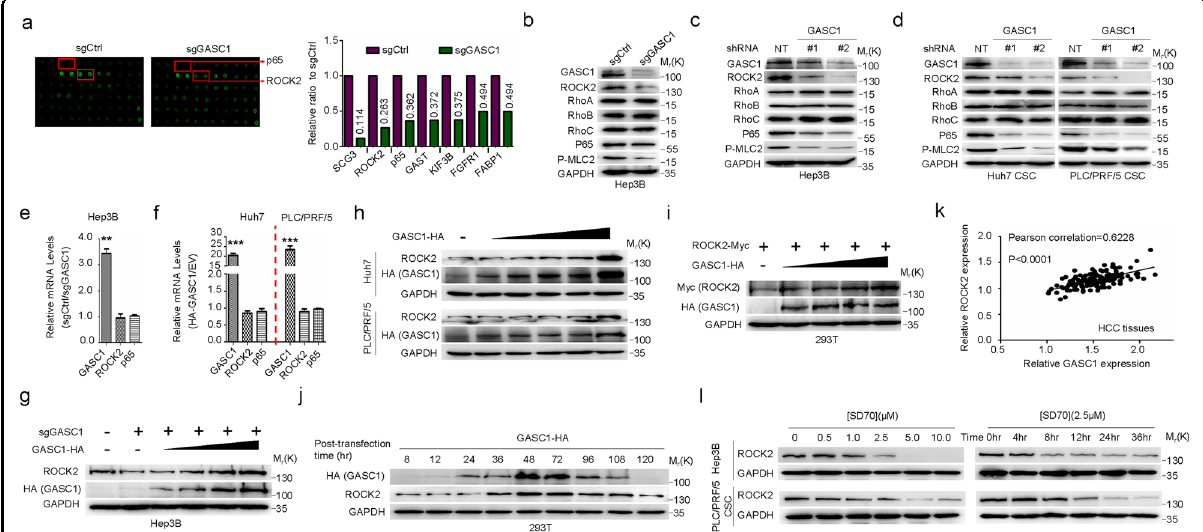
Fig. 3 GASC1 positively regulates ROCK2 protein level through a mechanism dependent on its histone demethylase activity. a High-density protein microarray screening analysis of cell lysates from cultured control and GASC1-depleted Hep3B cells. Proteins signi fi cantly downregulated by GASC1 depletion were summarized in the bar graph. b Immunoblotting (IB) analysis using the indicated antibodies in Hep3B GASC1 knockout (KO) cells. c , d IB analysis using the indicated antibodies in Hep3B ( c ), Huh7 CSC ( d , left), and PLC/PRF/5 ( d , right) CSC cells infected with shGASC1 and NT shRNA for 72 h. e , f qRT-PCR analysis of GASC1, ROCK2, and p65 mRNA levels in Hep3B GASC1 knockout cells ( e ) or HA-GASC1 over-expressed Huh7 and PLC/PRF/5 cells ( f ). Error bars represent SEM of three independent experiments. ** P < 0.01 and *** P < 0.001 by Student ’ s t test. g – i IB analysis of whole-cell lysates (WCL) derived from Hep3B GASC1-KO cells ( g ), Huh7 and PLC/PRF/5 cells ( h ), and HEK293T cells ( i ) transfected with indicated plasmids for 48 h. j ROCK2 levels in HEK293T cells were monitored during the indicated time frame after transfection of HA-GASC1 plasmid (8 h to 120 h post transfection). k GASC1 and ROCK2 gene expression positively correlate with each other in HCC clinical specimens. l IB analysis of ROCK2 in Hep3B and PLC/PRF/5 CSCs after treatment with increasing doses of SD70, an inhibitor of the GASC1 histone demethylase activity, for 48 h (left panel); or 2.5 μ M SD70 for increasing lengths of time as indicated (right